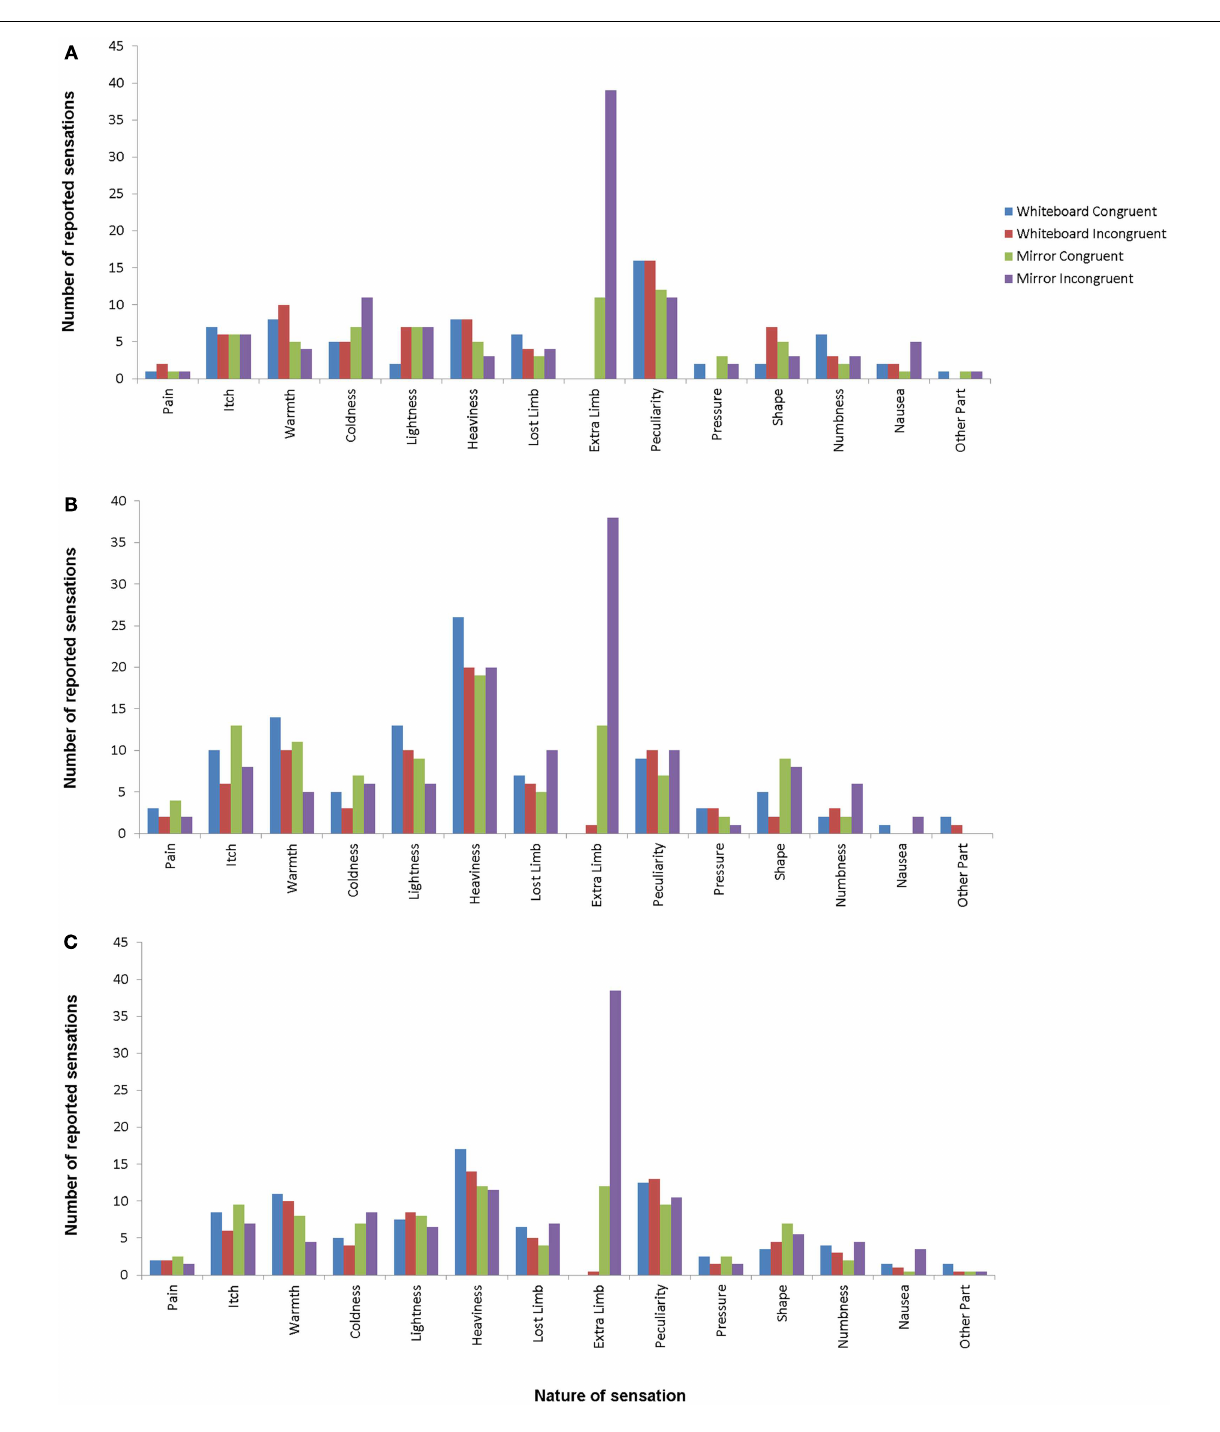
FIGURE 2 | Response frequencies for hand conditions (A), arm conditions (B), and average for all conditions (C) . Different bars indicate different conditions, with mirror/incongruent being the experimental condition. Item definitions are given in Table 1